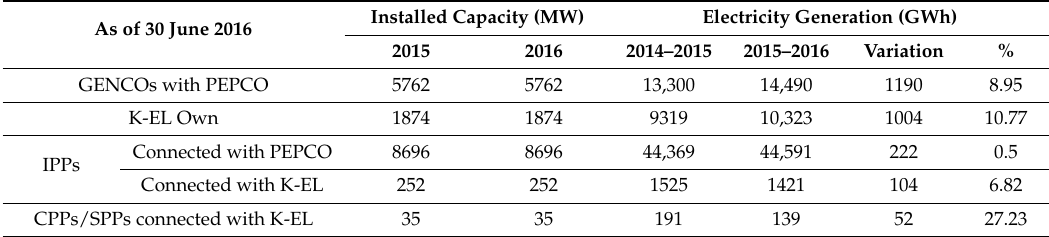
Table 7. Thermal installed capacity and electricity generation for 2015 and 2016. CPP: captive power producers, IPP: independent power producers, GWh: gigawatt hours, K-EL: K-Electric.